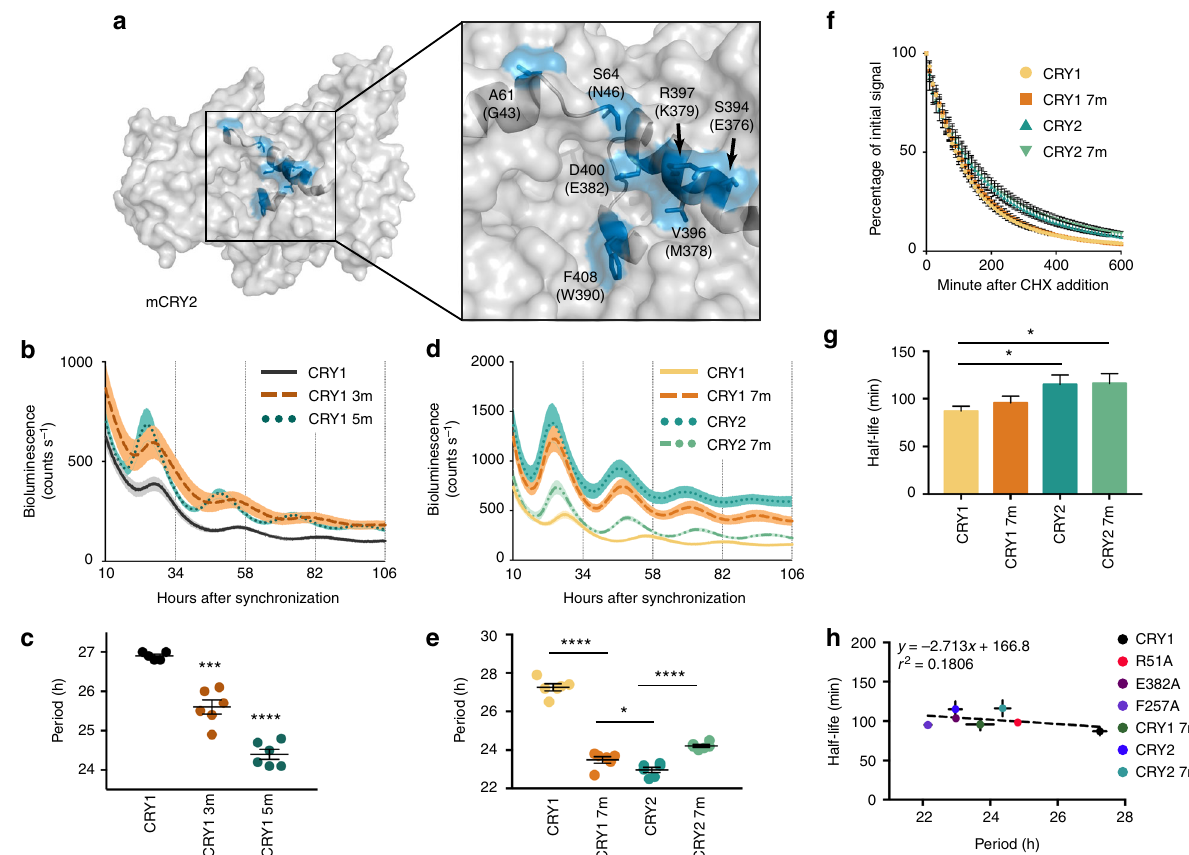
Fig. 6 Subtle divergence between CRY1 and CRY2 at the secondary pocket largely dictates periodicity differences between the two repressors. a Surface view of the secondary pocket in CRY2 (PDB: 4I6E) with the seven divergent paralogous residues of CRY1 and CRY2 colored blue and labeled. CRY1 residues are shown in parentheses. b Rescue assays performed with WT CRY1, CRY1 3m (CRY1 M378V/K379R/E382D), and CRY1 5m (CRY1 E376S/ M378V/K379R/E382D/W390F) shown as mean ± SEM ( n = 5, 6, 6 per condition, re fl ective of 18 plates each from 6 independent experiments). c Period plot of rescues in b . Mean± SEM indicated by bars. Asterisks show signi fi cance by unpaired t test with Welch ’ s correction (*** p = 0.0005, **** p < 0.0001) compared to WT. d Rescue assays performed with WT CRY1, CRY1 7m (CRY1 G43A/N46S/E376S/M378V/K379R/E382D/W390F), WT CRY2, and CRY2 7m (CRY2 A61G/S64N/S394E/V396M/R397K/D400E/F408W) ( n = 6 per condition, re fl ective of 30 (CRY1 7m), 33 (CRY2), and 24 (CRY2 7 m) plates from ≥ 8 independent experiments) shown as mean ± SEM. e Period plot of rescues in d . Mean± SEM indicated by bars. Asterisks show signi fi cance by unpaired t test with Welch ’ s correction (* p = 0.0387, **** p < 0.0001). f Degradation assay with CRY1::LUC and CRY2::LUC and mutants ( n = 6 per condition, 2 independent experiments). Samples were normalized to the initial luminescent signal. g Half-lives shown as mean ± SEM. Half-life was determined by fi tting a one-phase decay curve to the data. Asterisks show signi fi cance by unpaired t test with Welch ’ s correction (* p < 0.05 (CRY2 vs. CRY1: p = 0.0407; CRY2 7 m vs. CRY1: p = 0.0376), NS (CRY1 7m vs. CRY1: p = 0.3484; CRY2 7m vs. CRY2: p = 0.9348; CRY2 vs. CRY1 7 m: p = 0.1483; CRY2 7m vs. CRY1 7 m: p = 0.1331)). h Correlation plot of period vs. half-life for the various pocket mutant rescues. Half-lives and periods shown as mean ± SEM. Linear regression is shown as a dotted line. The slope ’ s deviation from zero was not signi fi cant ( p =